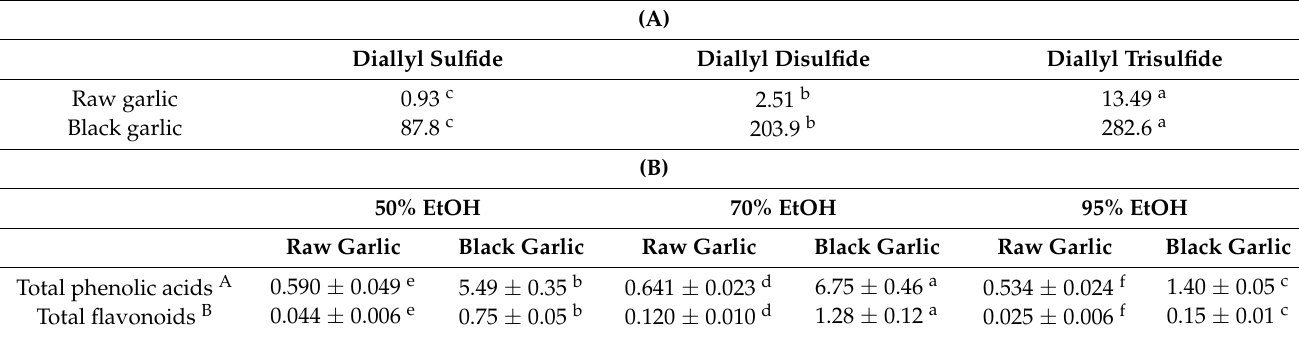
Table 1. ( A ) Contents ( µ g/g) of organosulfur compounds in raw and black garlic by GC-MS analysis. ( B ) Effect of different ethanol proportion on the contents of total phenolic acids and total flavonoids in raw and black garlic by UPLC- MS/MS